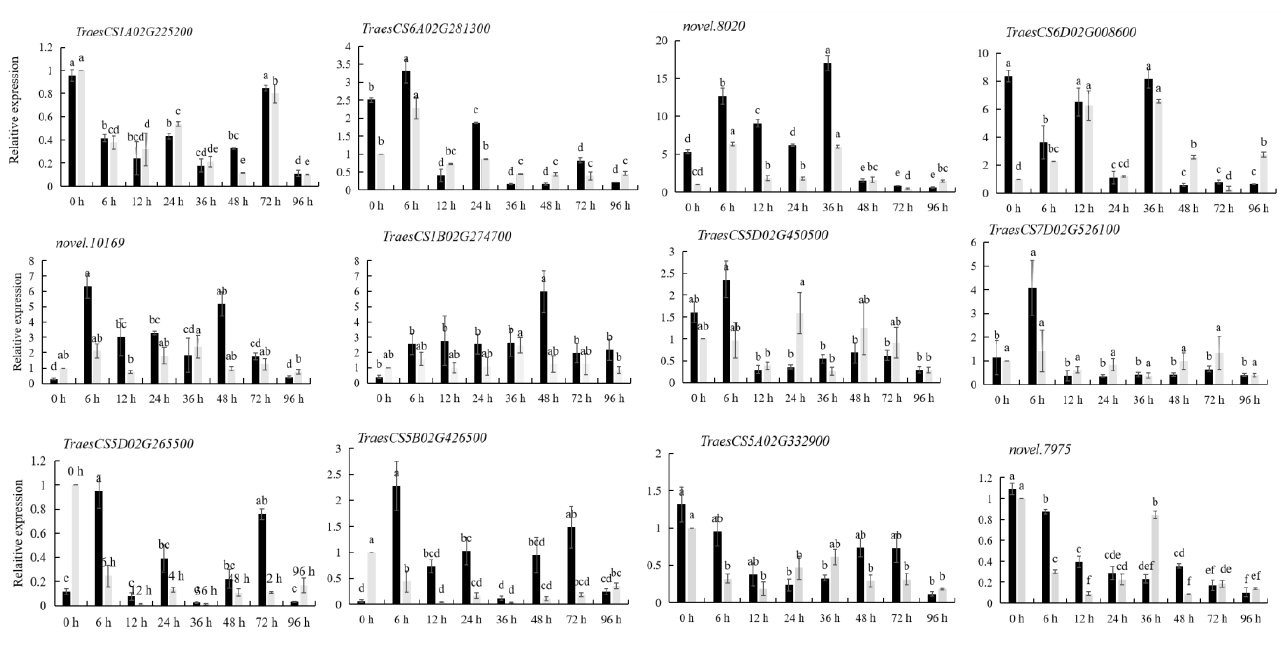
Figure 7. Relative expression levels of hub genes in materials WAT-2020-17-6 and W-2020-17-1. The x-axis represents the time points after inoculation with powdery mildew, and the y-axis represents the relative gene expression. The black column represents the material WAT-2020-17-6, and the gray column represents the test material W-2020-17-1. Different letters represented significant differences ( p < Table 1. Functional prediction of hub genes.